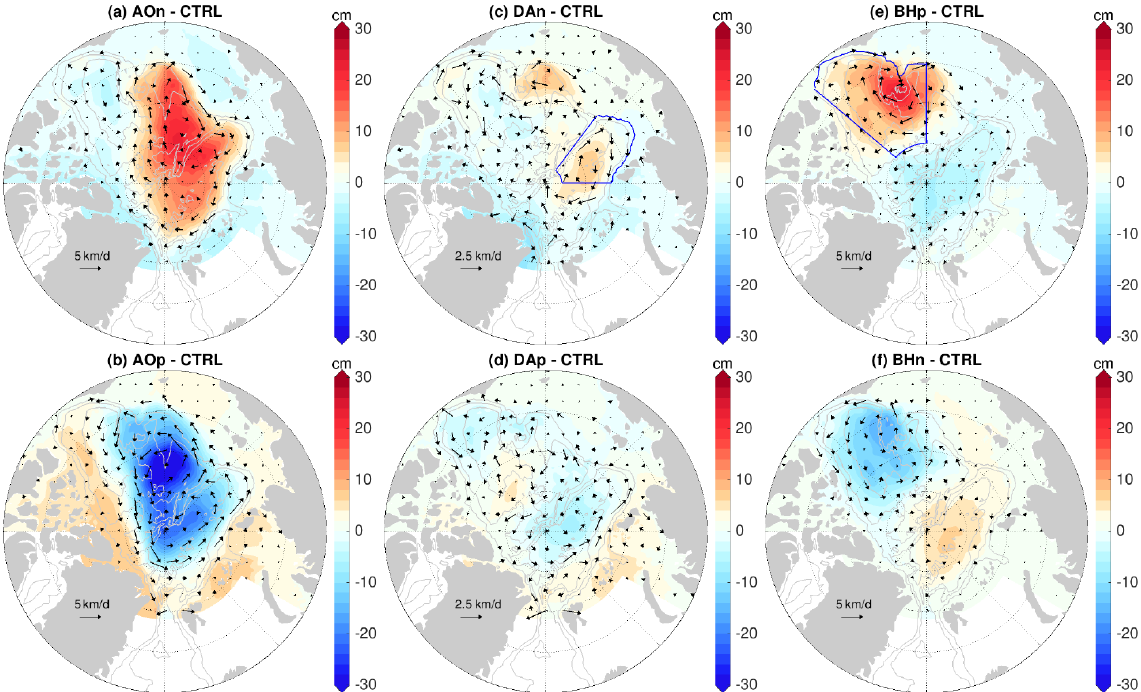
Figure 4. Anomaly of simulated sea surface height (SSH, patch color) and surface geostrophic current (arrows) relative to the control run averaged over the four model years of the sensitivity simulations in which wind perturbations were switched off: experiments with an initial ocean spun up with the (a) negative phase of Arctic Oscillation (AO) forcing, (b) positive phase of AO forcing, (c) negative phase of Dipole Anomaly (DA) forcing, (d) positive phase of DA forcing, (e) positive phase of Beaufort High (BH) forcing and (f) negative phase of BH forcing. Note that the scaling for velocity arrows in the DA cases is different from other cases. The SSH anomalies can be explained by the halosteric height anomalies shown in Fig. 3. The gray contour lines indicate the 500, 2000 and 3500m isobaths. The blue lines in (c) and (e) indicate the eastern Eurasian Basin and the Canada Basin, respectively, which are used in Fig.